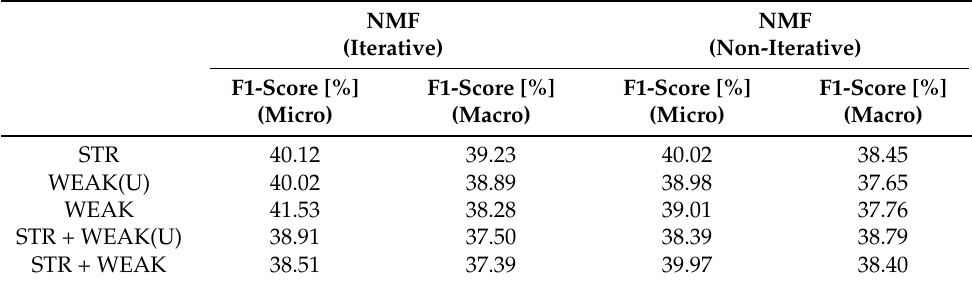
Table 3. Comparison results with different frequency basis matrices from various parts of the